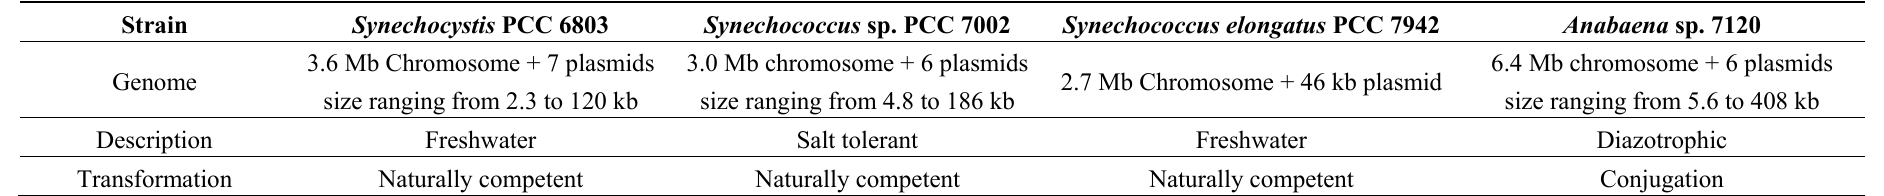
Table 1. Model cyanobacteria strains.